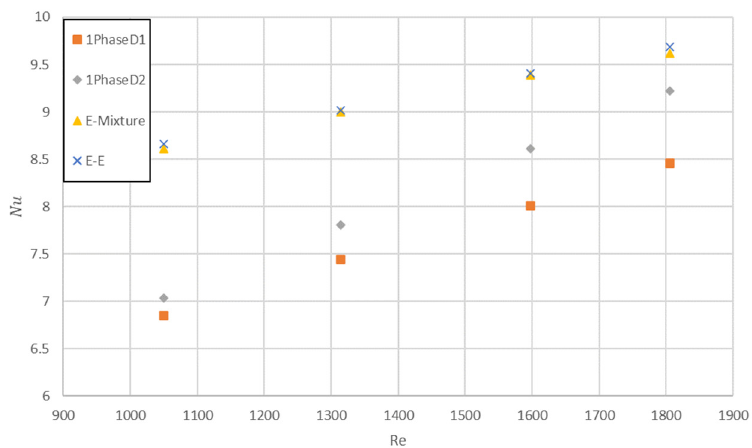
Figure 4. Nu-Re relationship for water–Al 2 O 3 (1.6%) nanofluid and x/D = 116—data source Figure 4. Nu ‐ Re relationship for water–Al 2 O 3 (1.6%) nanofluid and x/D = 116—data source [39]. Saha and Paul [40] studied the influence of nanoparticle size, NPC, and Brownian motion on heat transfer and WSS during the turbulent flow of a nanofluid inside a uni ‐ formly heated tube. The single ‐ phase approach with k ‐ε turbulence model was applied to solve governing equations. It was established that heat transfer is more affected by the diameter of nanoparticles and Brownian motion than the thermal conductivity of a nanofluid. Bianco et al. [41] studied the influence of NPC on the turbulent flow of nanoflu ‐ ids in tubes with a constant wall temperature. A mixture model of nanofluid with k ‐ε turbulence model was adopted. Although Nu number increases with NPC increase, PD increases more, so the application of nanofluids is questionable. In [42] Saha and Paul applied a Eulerian–Eulerian multi ‐ phase mixture model to analyze the turbulent flow of nanofluids in a uniformly heated tube. It was found that heat transfer performance deter ‐ mined by the multi ‐ phase mixture model is better than the single ‐ phase model [40]. Aghaei et al. [43] simulated the effect of NPC and nanoparticle diameter on the turbulent behavior of nanofluids during flow in tube with a constant temperature. A mixture model with k ‐ε turbulence model was applied. It was shown that there is an optimum value for the Nu number depending on the NPC. Moreover, the increase of nanoparticle diameter results in a Nu number decrease. Minea [44] studied the turbulent flow of nanofluids in a long tube with an isothermal entrance zone and a uniformly heated section of the devel ‐ oped region. A single ‐ phase approach with the k ‐ε turbulence model has been applied. It was established that HTC increases monotonically with NPC. Although PP increases with NPC in three case studies, the opposite trend was determined in one case study. Nasiri ‐ lohesara [45] stated that the enhancement of heat transfer with NPC increased during tur ‐ bulent nanofluid flow inside a tube ‐ in ‐ tube heat exchanger. However, the HTC rate of increase was less than the WSS increase. A mixture model of nanofluid with k ‐ε turbu ‐ lence model was applied. Ehsan and Noor [46] established a substantial enhancement of heat transfer during the flow of nanofluid in a rough tube compared to a smooth tube. Moreover, it was shown that there is an optimum value of NPC for which the PP is less than the base liquid. A single ‐ phase approach with an SST k ‐ω turbulence model was ap ‐ plied. Mahdavi et al. [47] tested different turbulence models by use of a mixture model and DPM implemented in ANSYS ‐ FLUENT code to study the behavior of nanofluids flow in uniformly heated tubes of various lengths and diameters. According to Mahdavi et al. the realizable and standard k ‐ε models provided the same results in most of the simula ‐ tions. The Reynolds stress model (RSM) overestimates PD compared with the other k ‐ε models, while the re ‐ normalization group (RNG) model overestimates HTC. The DPM model is recommended for the discussed cases, however, as it was stressed, the number of particles plays a key role in the simulations. Purohit et al. [48] studied the laminar flow